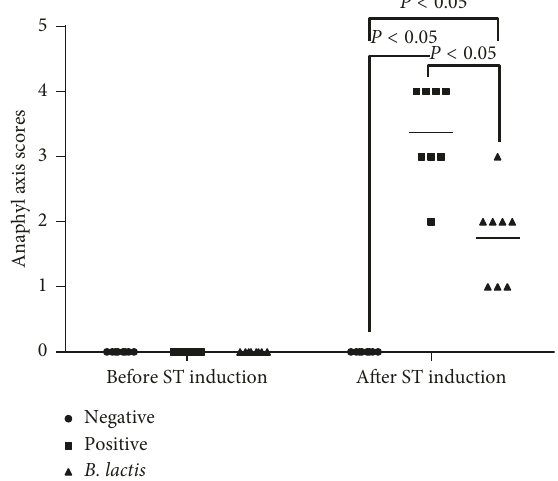
Figure 3: Shrimp tropomyosin-induced anaphylaxis in the mice among different groups. A total of 24 BALB/c mice were randomly divided into 3 groups ( n � 8 in each group): negative control group (NG), positive control group (PG), and experiment group (EG). The statistical difference was significant if P < 0 .